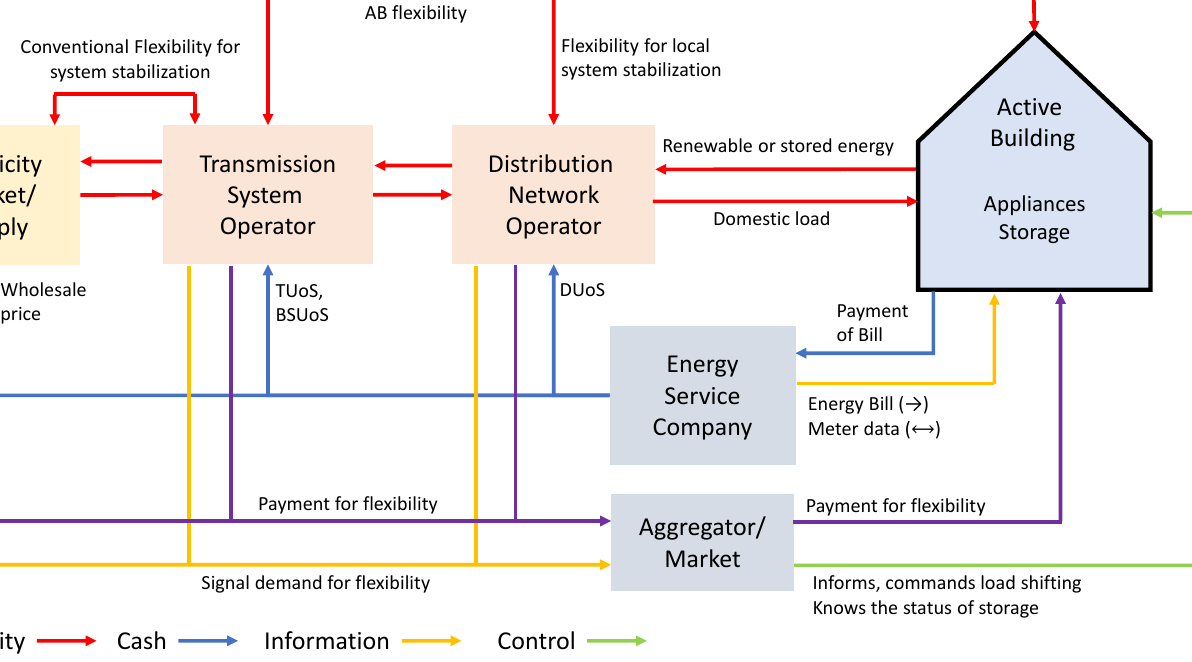
Figure 3. System flows involving Active